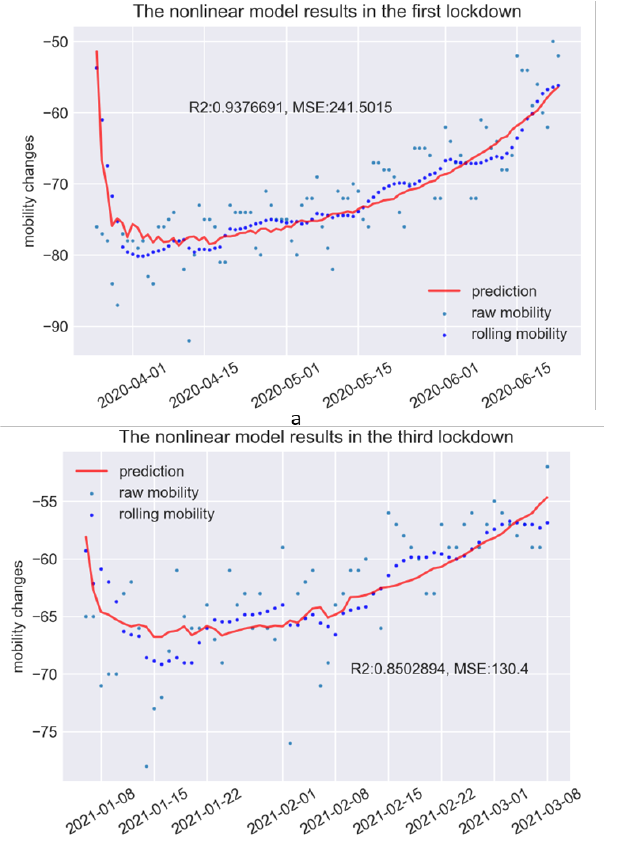
Figure 7. The nonlinear model results in each lockdown period.